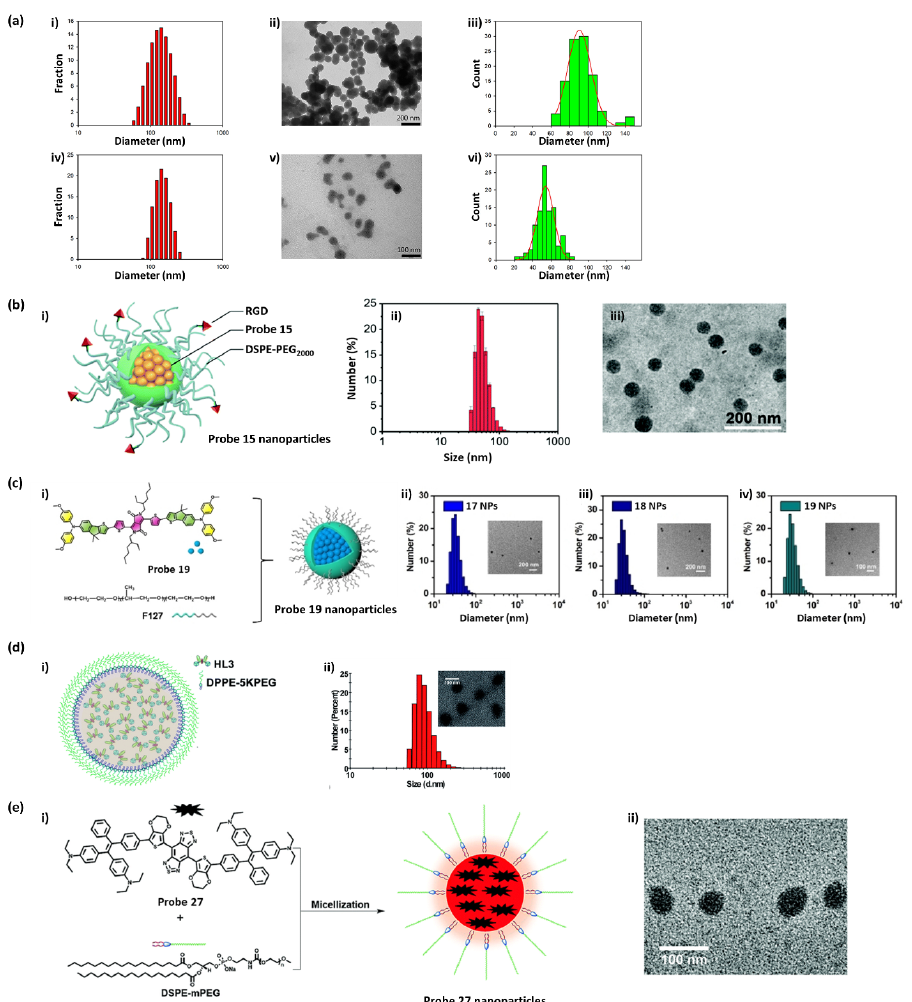
Figure 9. ( a -i) Size distribution obtained by dynamic light scattering (DLS) analysis of nanoparticles from probe 13 . ( a -ii) Representative transmission electron microscopy (TEM) image of probe 13 nanoparticles. ( a -iii) Size distribution resulting from the analysis of the TEM images of probe 13 nanoparticles. ( a -iv) Size distribution obtained by DLS analysis of probe 14 nanoparticles. ( a -v) Representative TEM image of probe 14 nanoparticles. ( a -vi) Size distribution resulting from the analysis of TEM images of probe 14 nanoparticles. Reprinted with permission from Ref. [103]. Copyright 2019, Frontiers Media SA. ( b –i) Schematic illustration of probe 15 nanoparticles. ( b -ii) TEM images of probe 15 nanoparticles. ( b -iii) Size measurement of probe 15 nanoparticles in water using DLS. Reprinted with permission from Ref. [111]. Copyright 2021, Royal Society of Chemistry. ( c -i) Schematic illustration of probe 19 encapsulating nanoparticles by Pluronic F127. The DLS spectrum of ( c -ii) probe 17 nanoparticles with F127, ( c -iii) probe 18 nanoparticles with F127, and ( c -iv) probe 19 nanoparticles with F127 (inset: TEM image of nanoparticles). Reprinted with permission from Ref. [116]. Copyright 2021, John Wiley and Sons. ( d -i) Formation of probe 22 nanoparticles via nanoprecipitation. ( d -ii) DLS and TEM images of probe 22 nanoparticles; scale bar: 100 nm. Reprinted with permission from Ref. [47]. NIR-II AIE nanoparticles (probe 23 nanoparticles) via micellization. ( e -ii) Representative TEM image